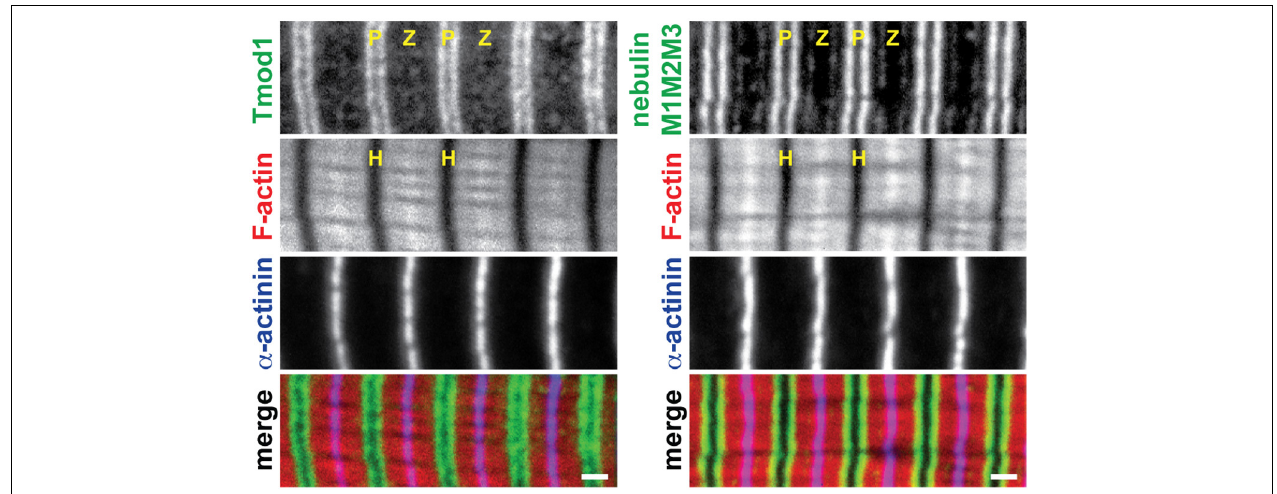
FIGURE 1 | Sample immunofluorescence images of P14 mouse muscles. Longitudinal TA cryosections were phalloidin-stained for F-actin and immunostained for α -actinin, along with either Tmod1 or nebulin M1M2M3, and imaged by confocal microscopy. P, thin filament pointed ends; Z, Z-line; H, H-zone. Bars, 1 μ m.